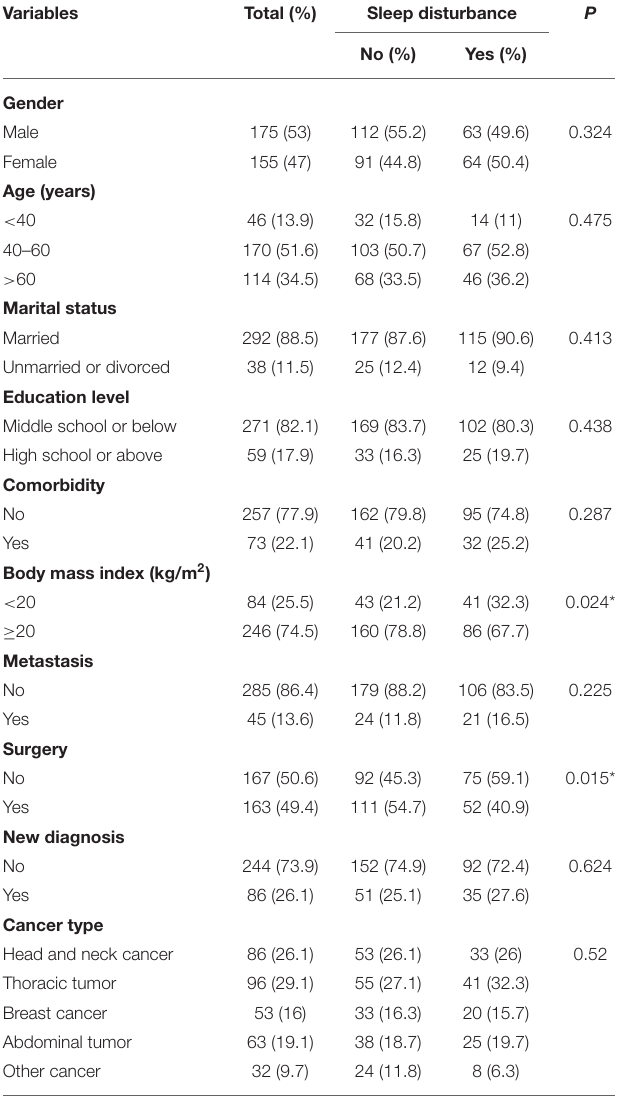
TABLE 1 | Sociodemographic and clinical characteristics of the patients with and without sleep disturbance.